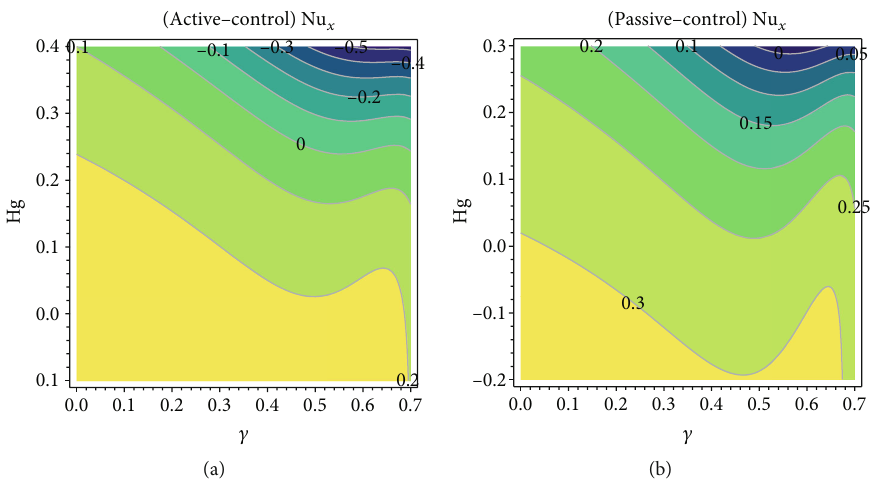
Figure 8: The e ff ect of Nusselt number for combined parameters Hg and γ